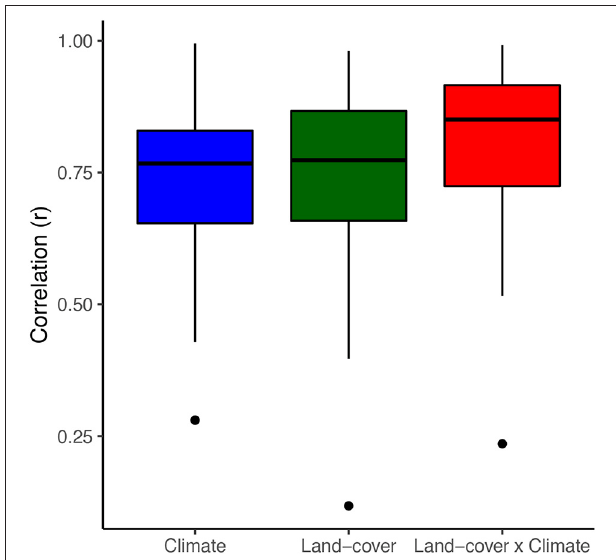
FIGURE 2 | Boxplot showing Spearman correlations for all species between model fit and independent test data (10-fold validation) for the same time period in which models were built (1983–1987). Models predicting bird abundance generally performed well when not projecting across time